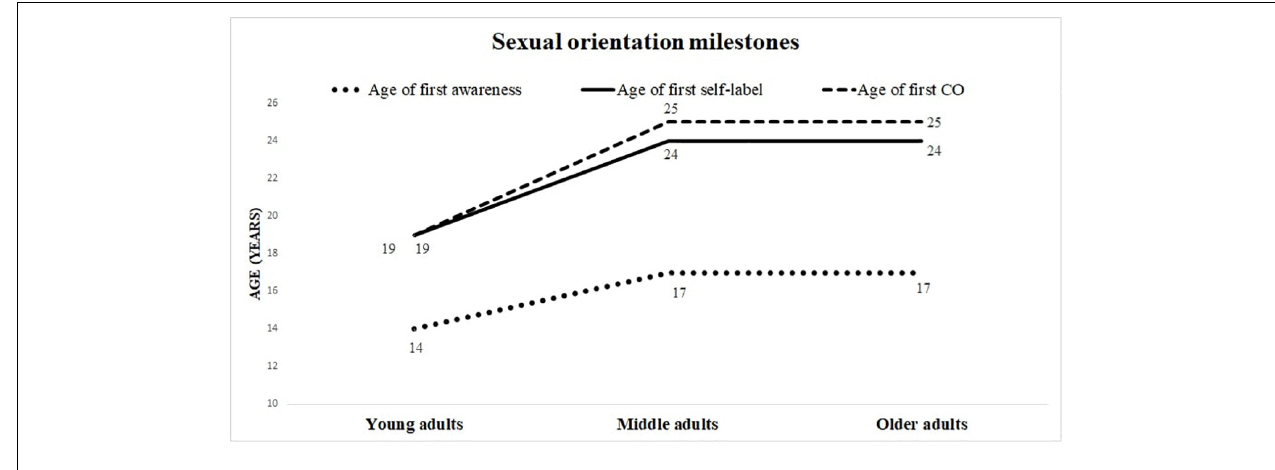
FIGURE 1 | Sexual orientation milestones.